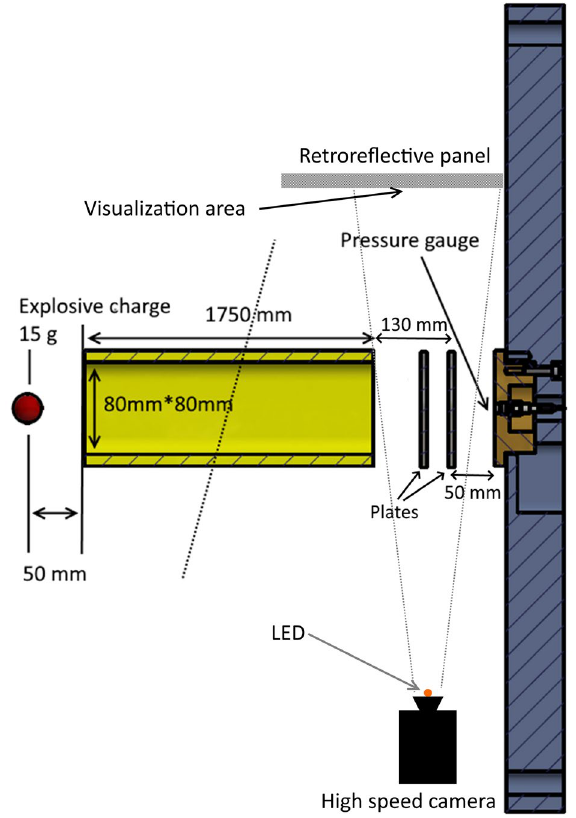
Fig. 1 Schematic view of the explosive-driven shock tube and posi- tioning of the pressure sensor and